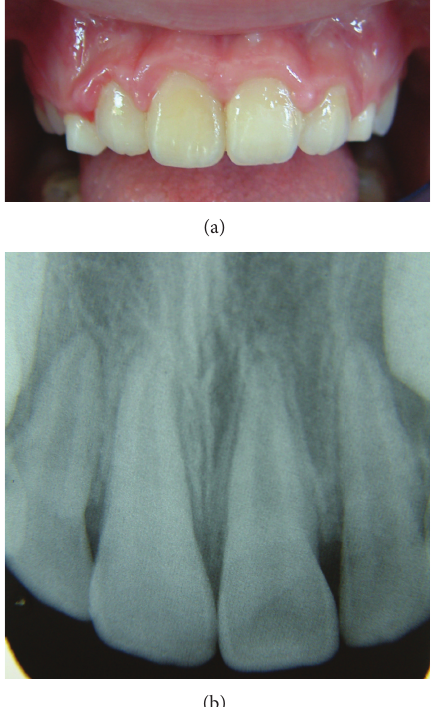
Figure 6: Clinical and radiographic view of the maxillary incisor at 2